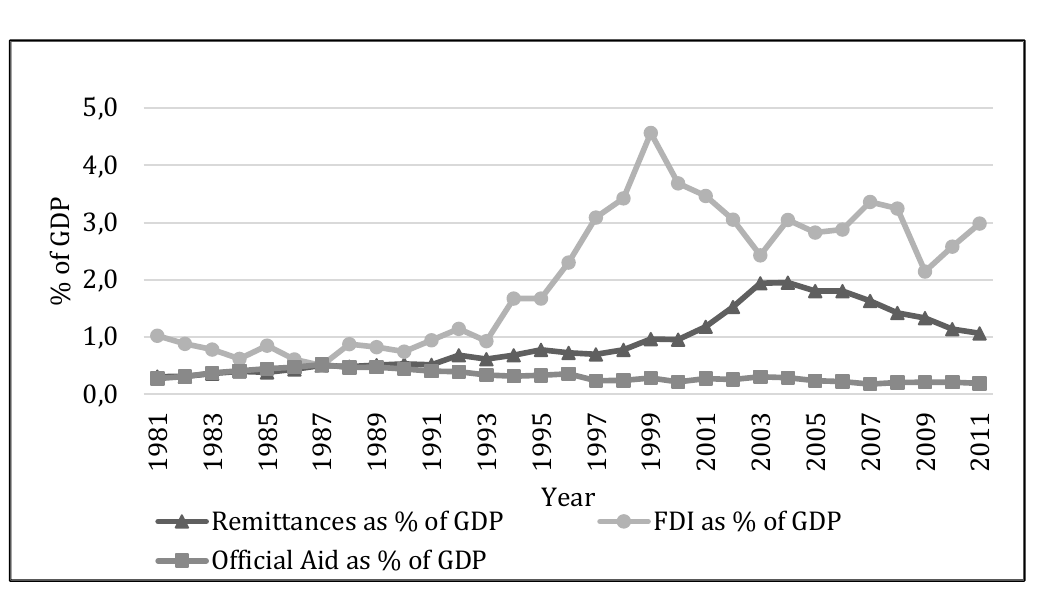
Figure 01. Remittance flows vs. foreign direct investment and government aid in Latin America and the Caribbean (1976 – 2014)